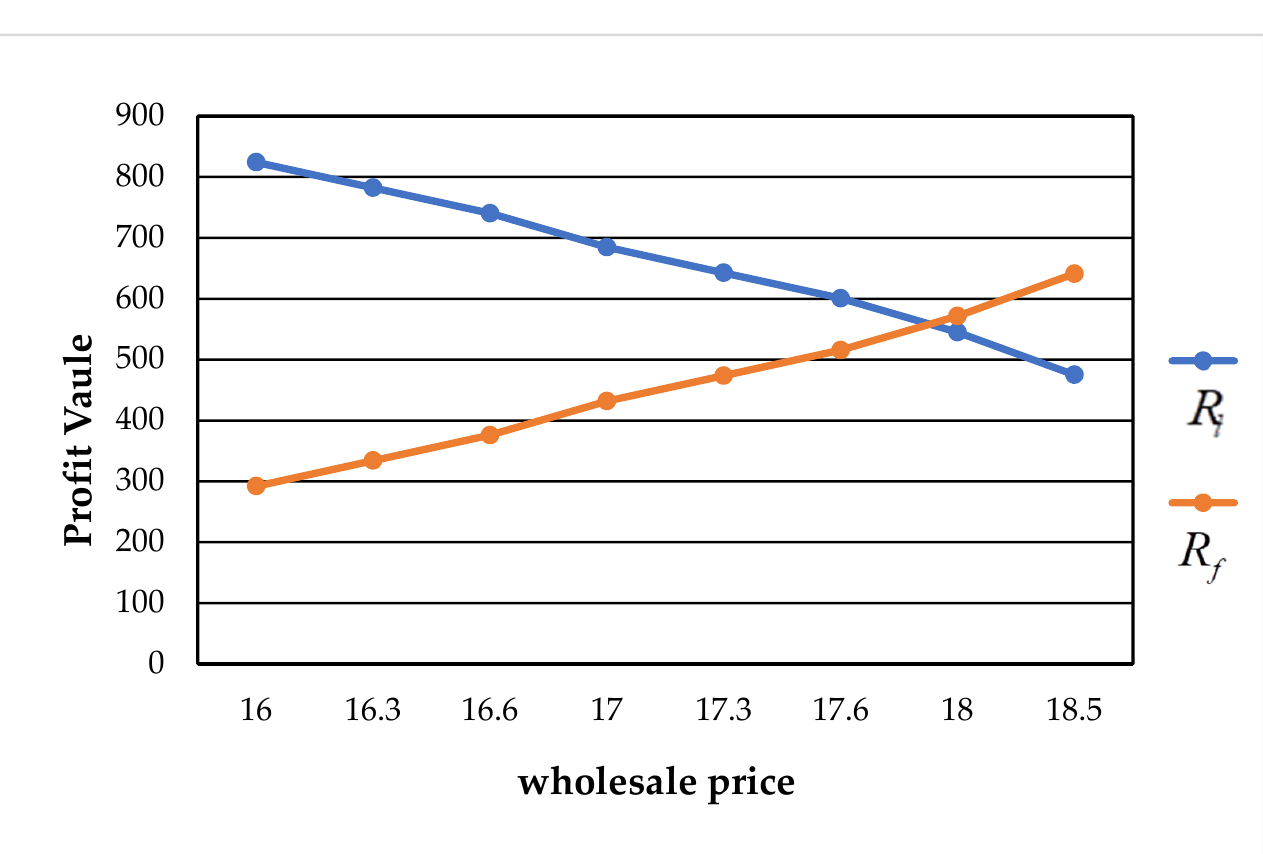
Figure 1. Sensitivity analysis of wholesale price coordination of agricultural products.